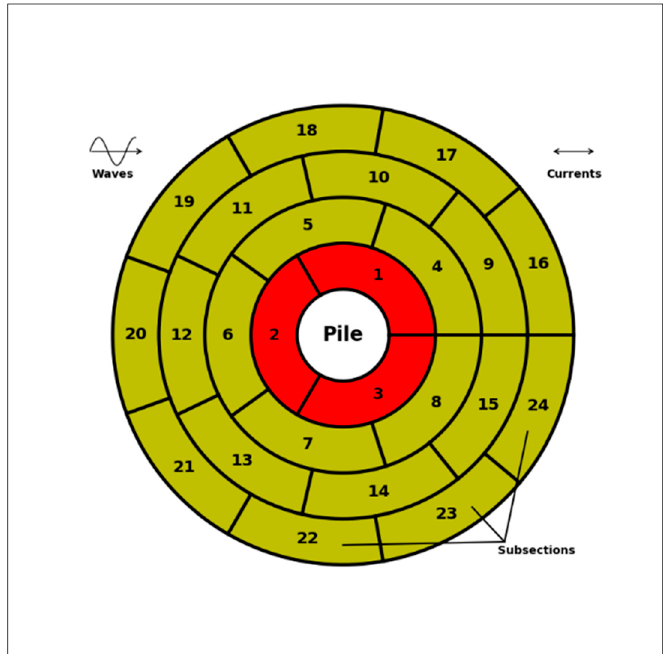
Figure 10. Sketch of the scour protection model around the monopile divided in subsections as in [8], with the inner ring in red. The waves and current propagation directions are also indicated. The decomposition in subsections is made depending on the direction of propagation of the current. The present setup is for a current propagation opposing waves, the setup should be mirrored if the current follows the waves.